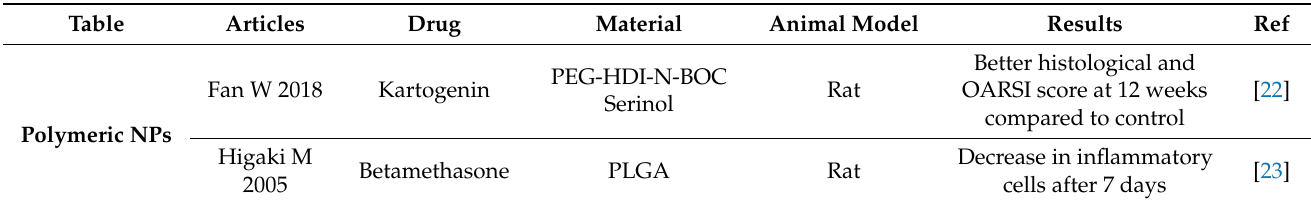
Articles Drug Material Animal Model